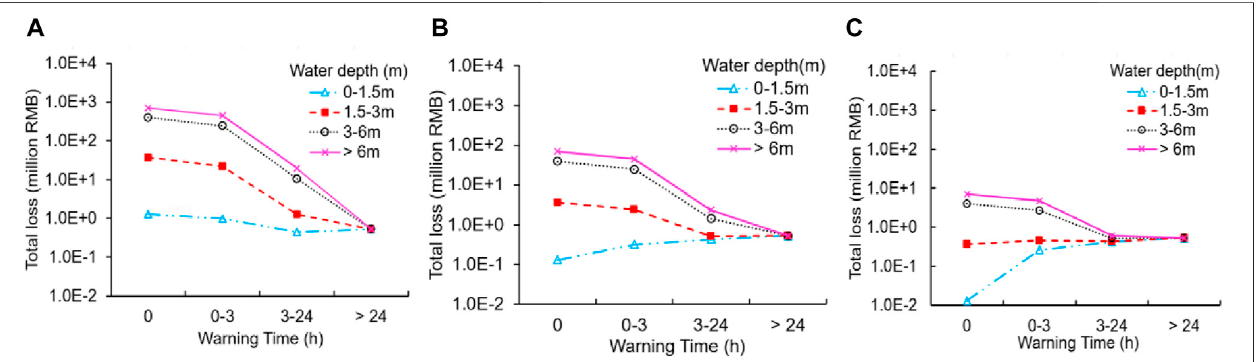
FIGURE 2 | Variation of total loss with W t and D w : (A) P f (cid:2) 1; (B) P f (cid:2) 0.1; (C) P f (cid:2) 0.01.